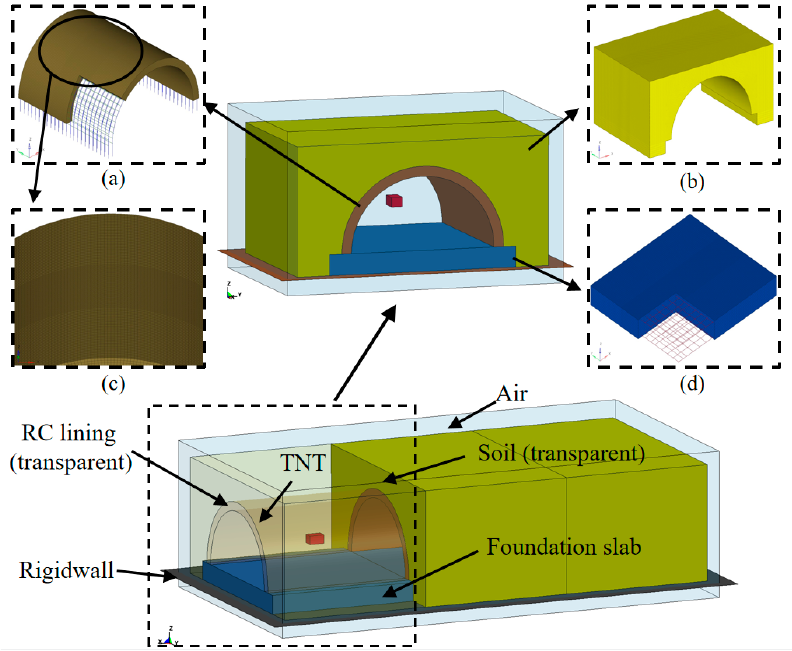
Figure 5. FE model of the blast test: ( a ) RC lining; ( b ) Soil layer; ( c ) Details of RC lining; ( d ) Foun- dation slab.